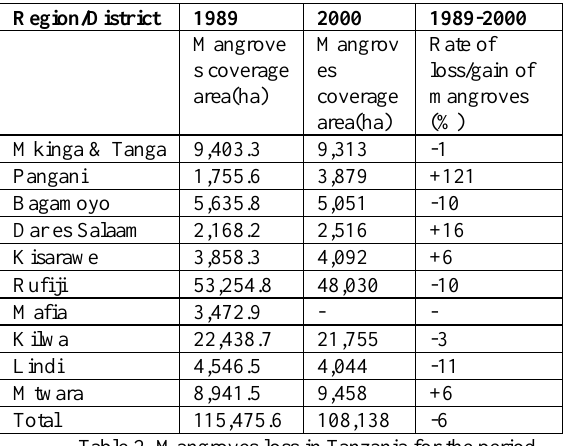
Table 2. Mangroves loss in Tanzania for the period between 1989 and 2000. Source: Semesi (1992) and Wang et al.,